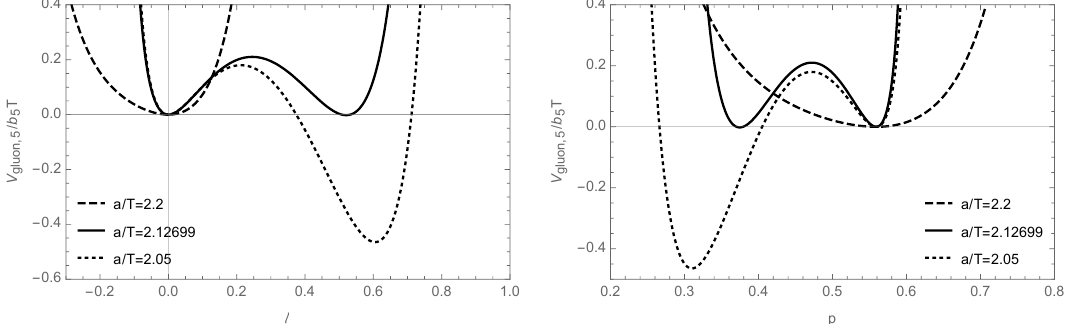
Figure 4 . The potential V gluon ; 5 ( L; T ) =b 5 T as a function of ‘ (left) and of p (right) on the straight line linking the two minimum points given in (3.33) and (3.35) around the critical temperature ~ a c = a=T c = 2 :